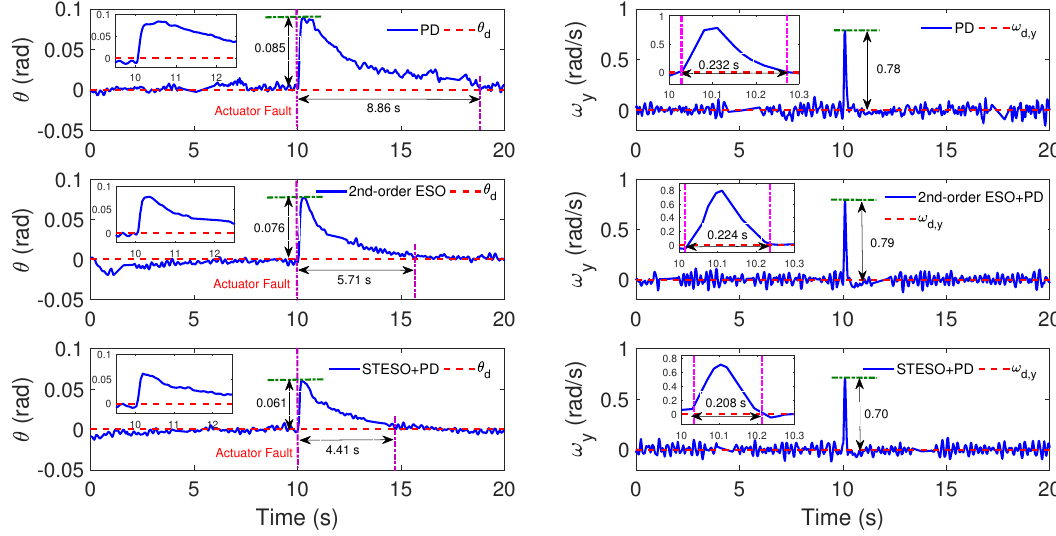
Figure 9. Experimental curves of θ and ω y with different DUE in Case